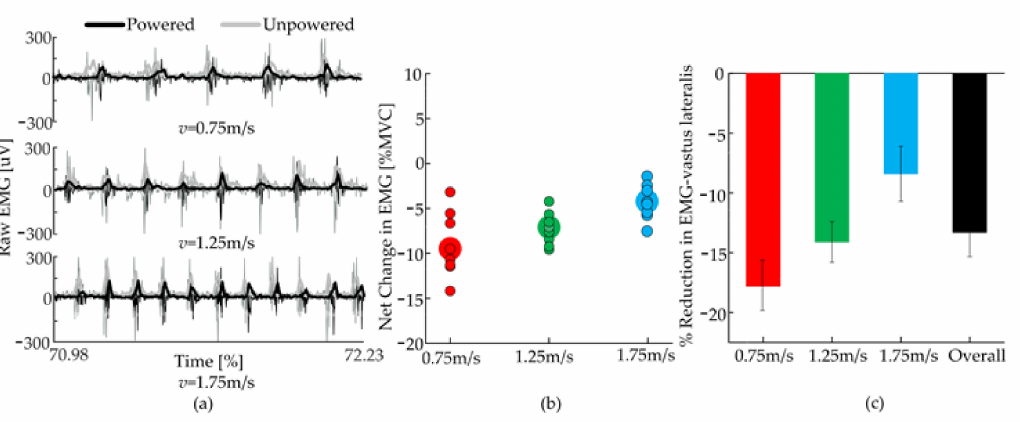
Figure 11. Changes in muscular activation. ( a ) Raw signal and envelope of the vastus lateralis’ EMG. ( b ) Net change (Powered—Unpowered) of RMS of the EMG signals of the vastus lateralis, for the three walking speeds. Opaque contoured circles are the values for each individual subject, bigger circles indicate the mean over subjects. ( c ) Changes in the activation of the vastus lateralis, expressed as a percentage of its activation in the unpowered condition (net change/Unpowered). Error bars show the standard error of the